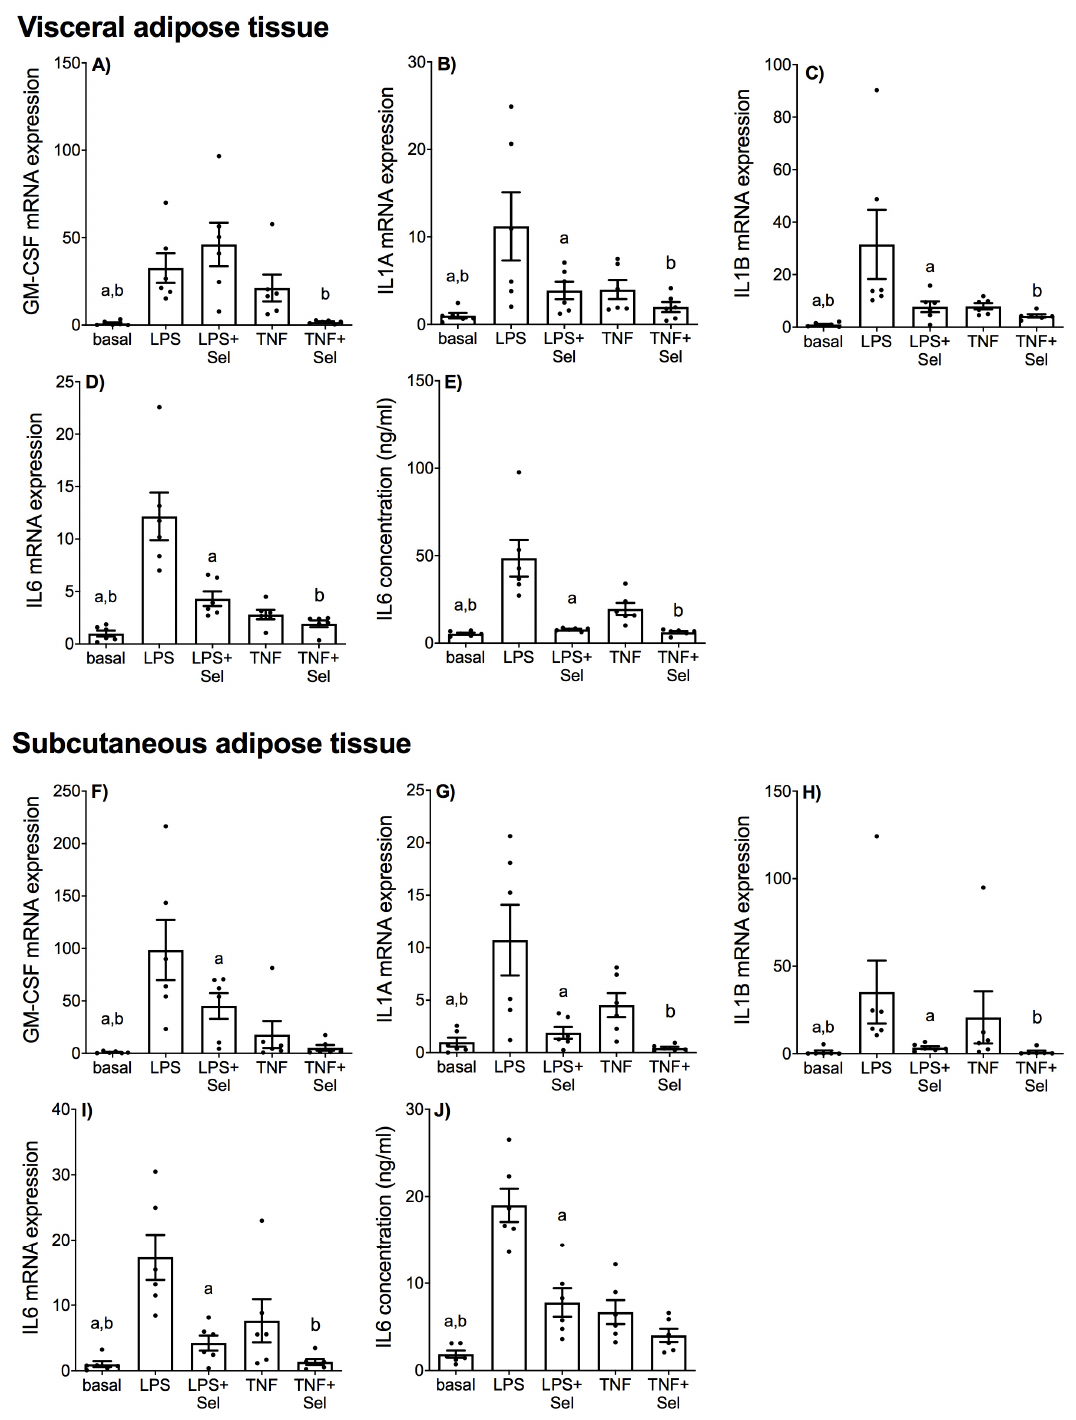
Figure 2. Effect of selenium on pro-inflammatory cytokine expression in VAT and SAT from pregnant women. ( A – E ) VAT ( n = 6 patients) and ( F – J ) SAT ( n = 6 patients) were incubated with or without 10 µM sodium selenite (Sel) for 1 h and then stimulated with 10 µg/mL LPS or 10 ng/mL TNF- α for a further 20 h. ( A – D , F – I ) GM-CSF, IL1-A, IL1-B and IL6 mRNA expression was analysed by RT-qPCR and fold change was calculated relative to basal expression. ( E , J ) The concentration of IL6 in the conditioned media was assayed by ELISA. For all graphs, individual data points represent six independent experiments and are displayed as mean ± SEM. a p ≤ 0.05 vs. LPS, b p ≤ 0.05 vs. TNF; repeated measures one-way